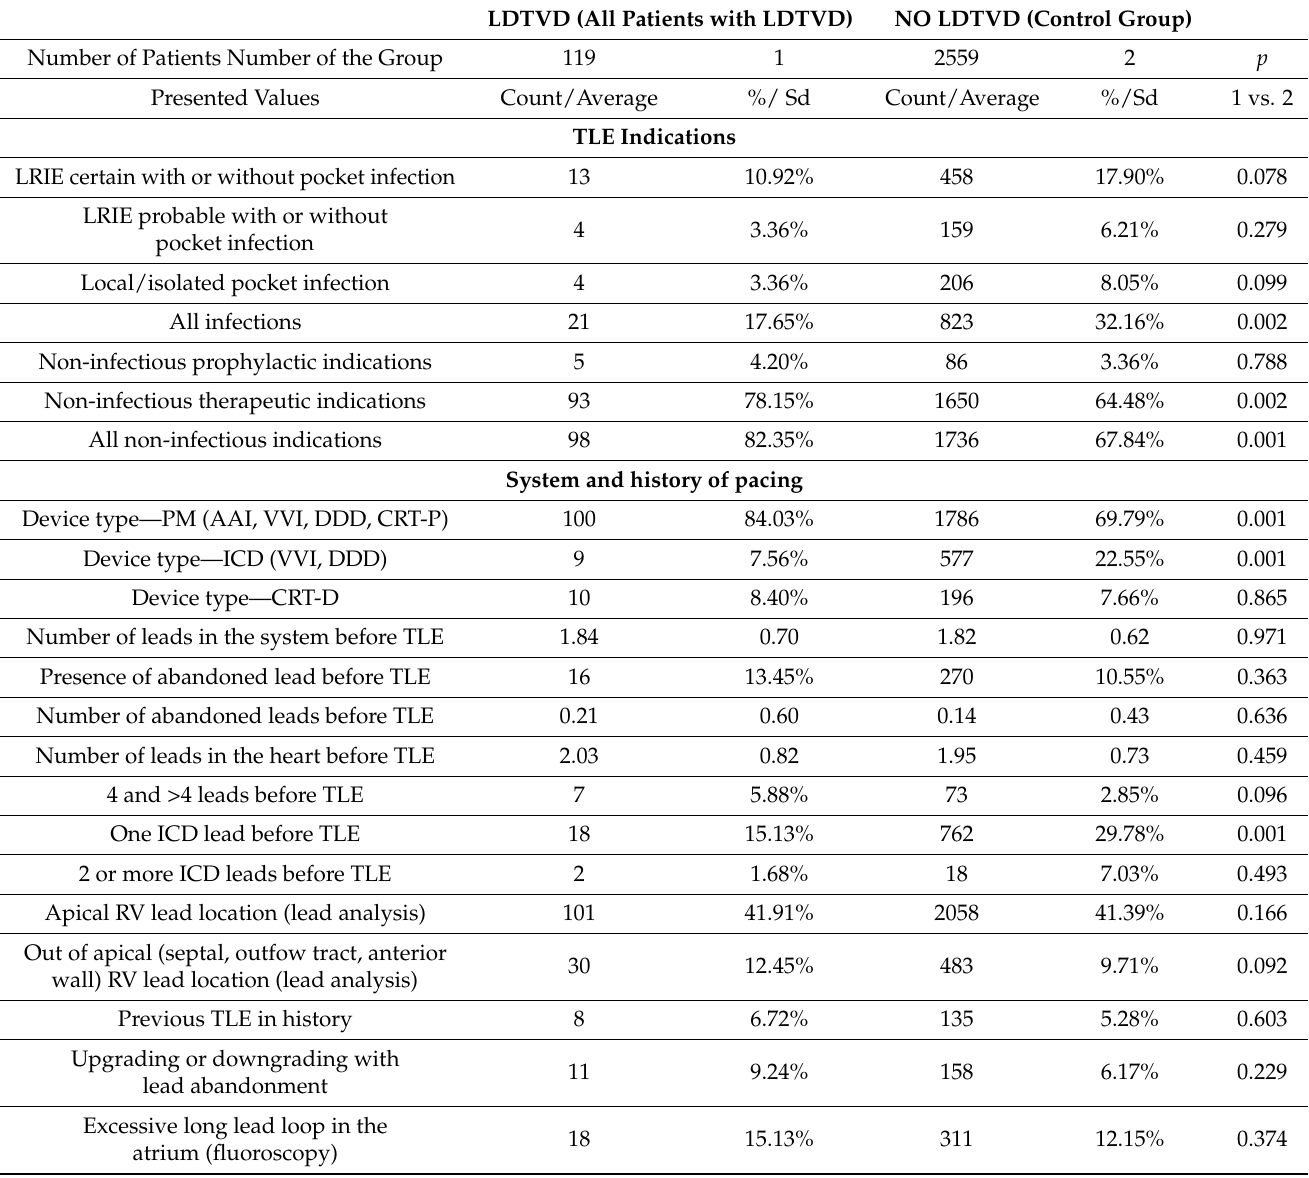
Table 3. Indication, system and history of pacing -related factors. Classification according to the occurrence of